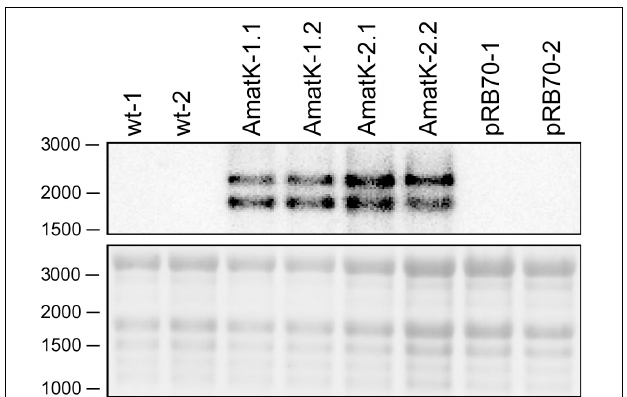
FIGURE 3 | Detection of synthetic matK transcripts from AmatK, wt and aadA leaf tissue using RNA gel blot hybridization. 5 µ g of total plant RNA was extracted and analyzed by RNA gel blot hybridization using a probe directed against the junction of the AmatK and HA sequence, which is specific to the transgene. The wt lines -1 and -2 as well as the AmatK lines -1 and -2 represent biological replicates.